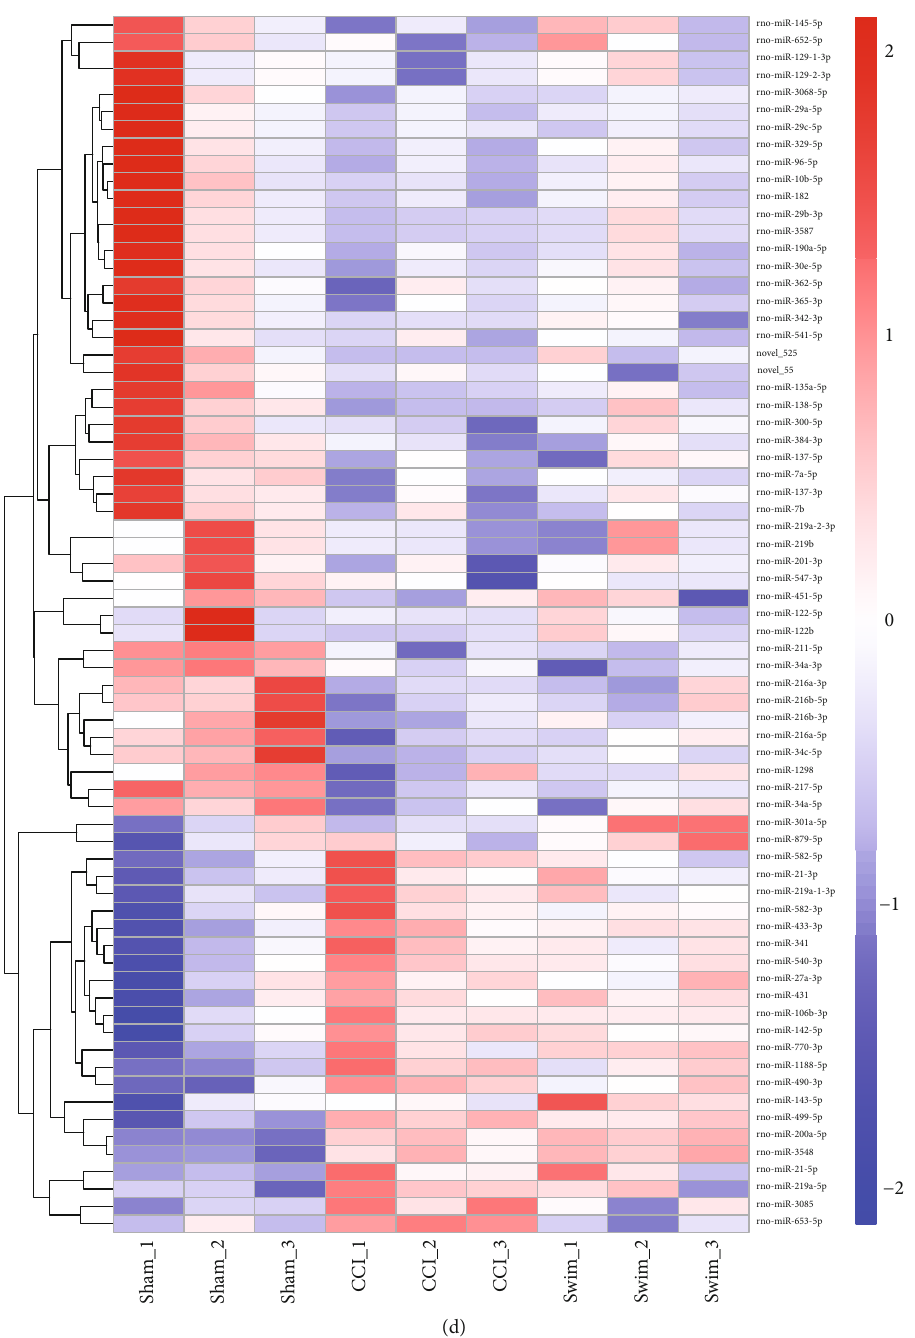
Figure 5: Expression pro fi le changes in microRNAs (miRNAs) in the dorsal root ganglion (DRG). (a) Volcano plots of RNA-sequencing data showing di ff erentially expressed miRNAs between the chronic constrictive injury (CCI) and sham-operated groups. (b) Volcano plot showing di ff erentially expressed miRNAs between the CCI and CCI-exercised groups. Magenta dots represent genes with signi fi cantly upregulated expression, blue dots represent genes with signi fi cantly downregulated expression, and grey dots represent genes with no signi fi cant di ff erence. (c) Overlap of di ff erentially expressed miRNAs between the two comparisons shown as a Venn diagram. (d) Heatmap showing the relative expression levels of di ff erentially expressed miRNAs among the three groups. Upregulated and downregulated genes are colored red and blue, respectively ( n = 3 animals per